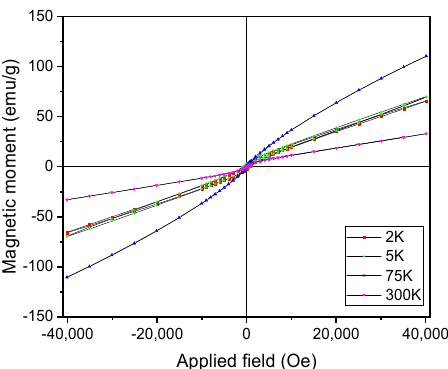
Figure 7. Major hysteresis loops of Mn 52 Al 46 C 2 alloy at various temperatures.